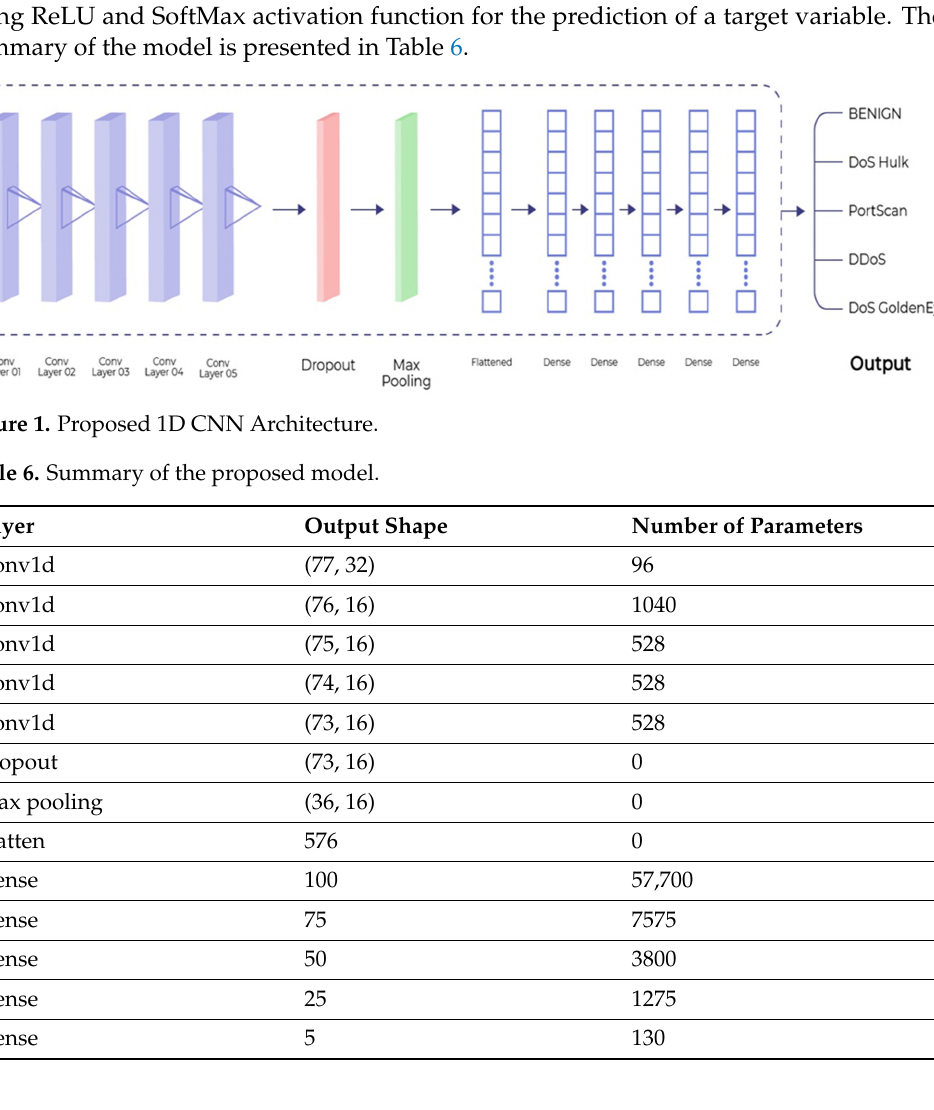
Table 7. Dataset Distribution. Instances